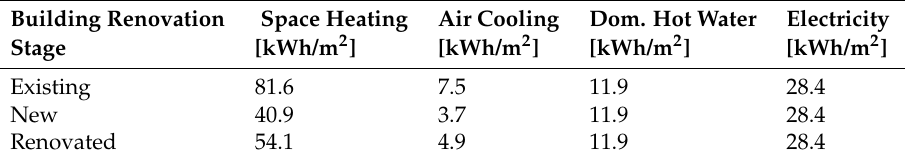
Figure A7. Hourly specific energy service demand of mixed buildings. Table A24. Yearly specific energy service demand of mixed